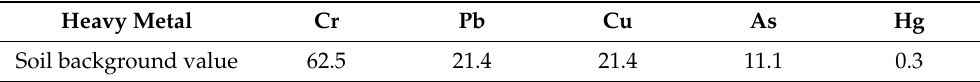
Table 3. Environmental background values of heavy metals in Shaanxi Province